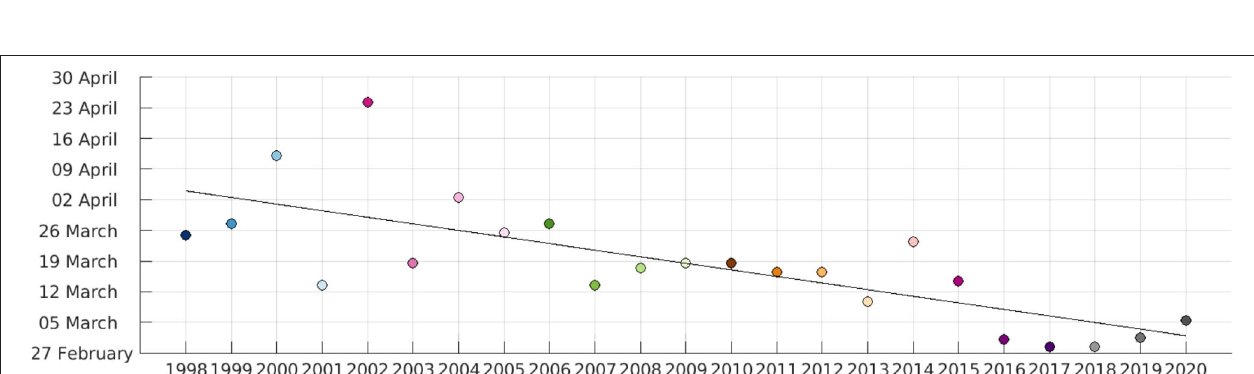
Frontiers in Marine Science |